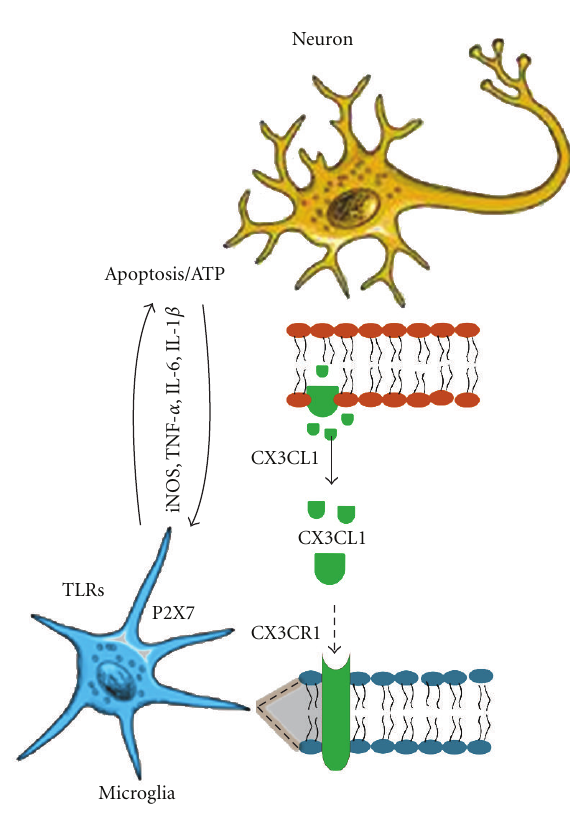
Figure 1: Initiation of inflammatory response following intra- neuronal protein accumulation. Intraneuronal accumulation of pathogenic proteins causes ATP release by apoptotic neurons to activate purinergic microglia P2X7 receptors or TLRs. Activated microglia release proinflammatory cytokines (TNF- α , IL-16, IL-1) and iNOS to activate astrocytes (via MCP-1 chemotaxis) and increase apoptosis in stressed neurons. To initiate a neuropro- tective immune response, injured neurons may communicate via fractalkine (CX3CR1) and suppress